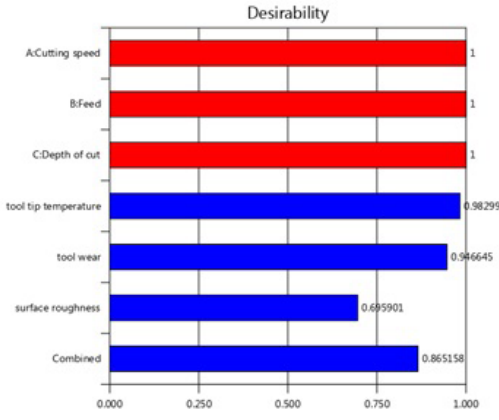
Figure 8. Bar graph of desirability of multi objective